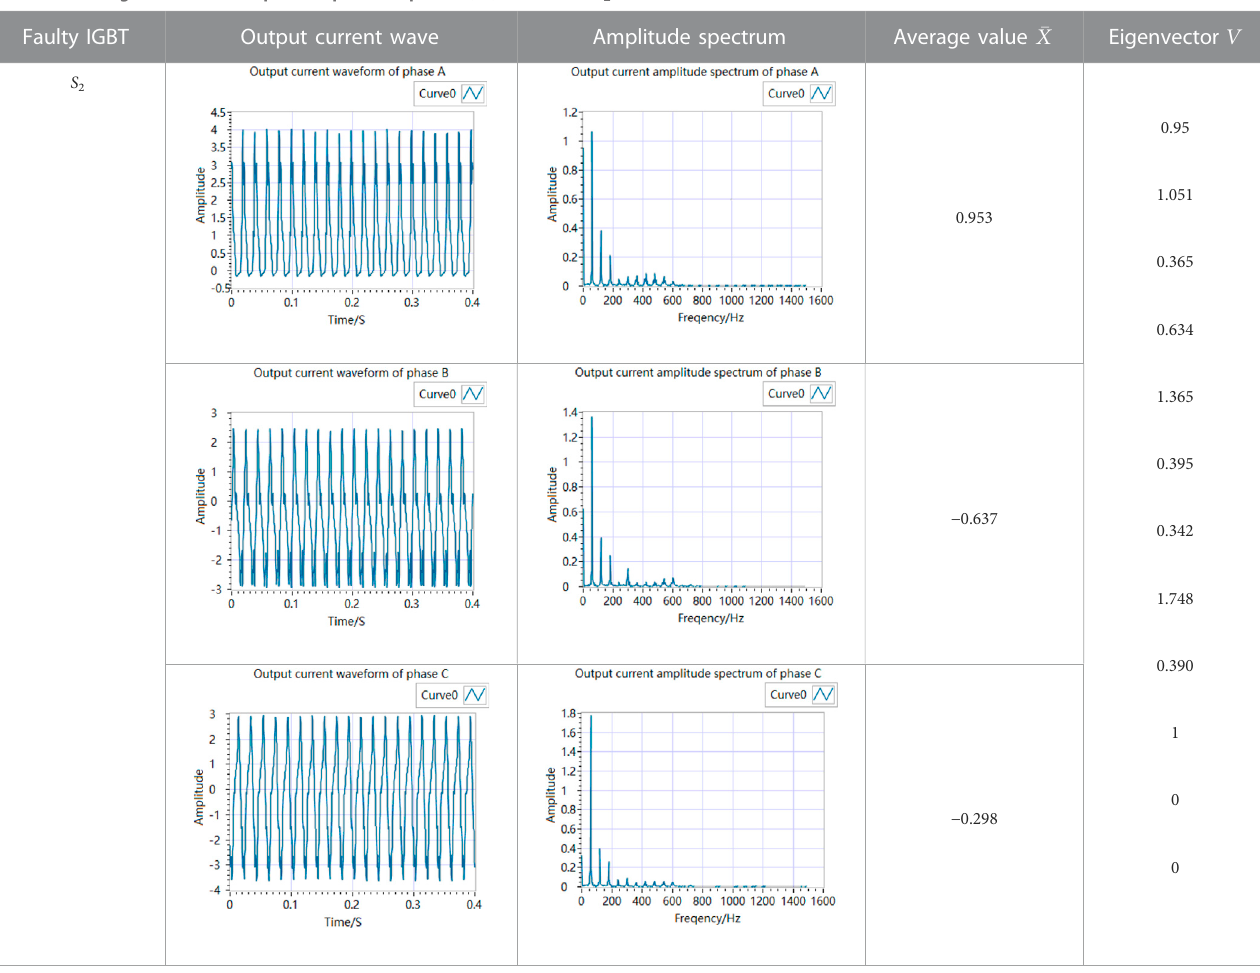
TABLE 1 Fault eigenvector and amplitude spectra of phase A, B, and C with S 2